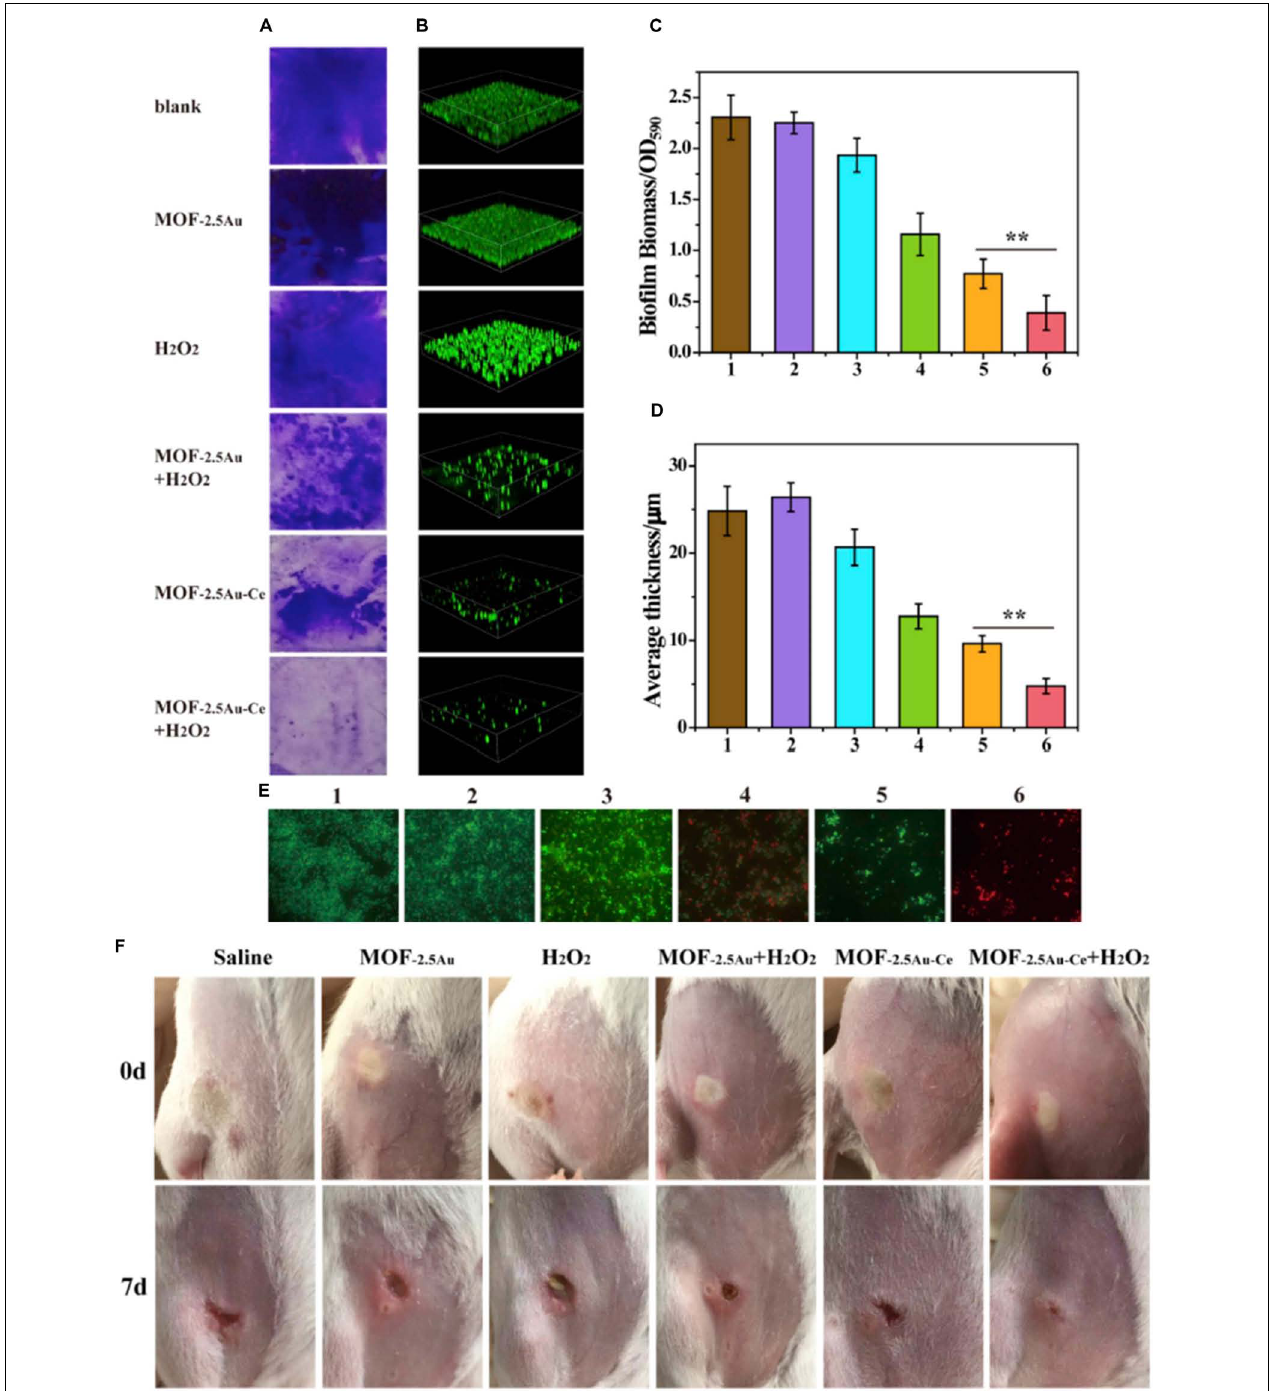
FIGURE 7 | The effect of MOF - 2 . 5 Au - Ce on inhibiting the formation of biofilms. (A,C) Crystal violet staining and (B,D) 3D CLSM imaging of biofilms incubated with different substances for 24 h. The biomass of biofilms was quantified by measuring OD 590 . Image sizes of CLSM: 315 µ m × 315 µ m. Quantitative analysis of biofilm thickness was with the help of the Comstat 2 software. (E) LIVE/DEAD stain images of residual biofilms in biofilm inhibition using fluorescence microscopy. Green and red stains signified viable and dead bacteria, respectively. Scale bar = 10 µ m. Group 1: control with culture medium only; group 2: treated with MOF - 2 . 5 Au ; group 3: treated with H 2 O 2 ; group 4: treated with MOF - 2 . 5 Au + H 2 O 2 ; group 5: treated with MOF - 2 . 5 Au - Ce ; group 6: treated with MOF - 2 . 5 Au - Ce + H 2 O 2 . The used nanomaterials were 200 µ g/ml, and H 2 O 2 was 0.5 mM. Error bars were calculated on the basis of three independent experiments. (F) Photographs of subcutaneous abscess in mice from the six groups at different times during the therapeutic process. Reprinted with permission from Liu et al. (2019), copyright 2019 Elsevier.